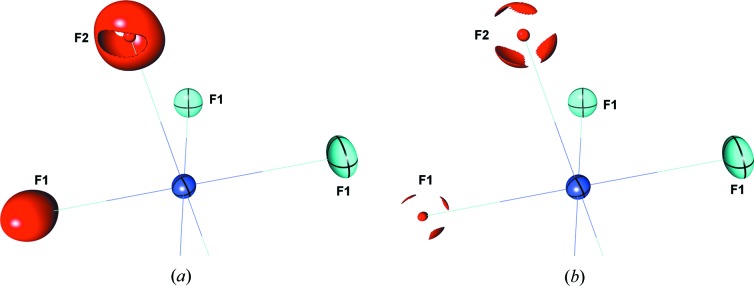
Envelope diagrams of the negative Laplacian distribution (charge concentration) around the fluorine atoms in the UF6
−. The isosurfaces are plotted at (a) −160 and (b) −190 e Å−5
­ levels. Thermal ellipsoids are drawn at the 99% probability level. While these distributions were obtained from model 1c, nearly identical distributions are obtained from model 1b.